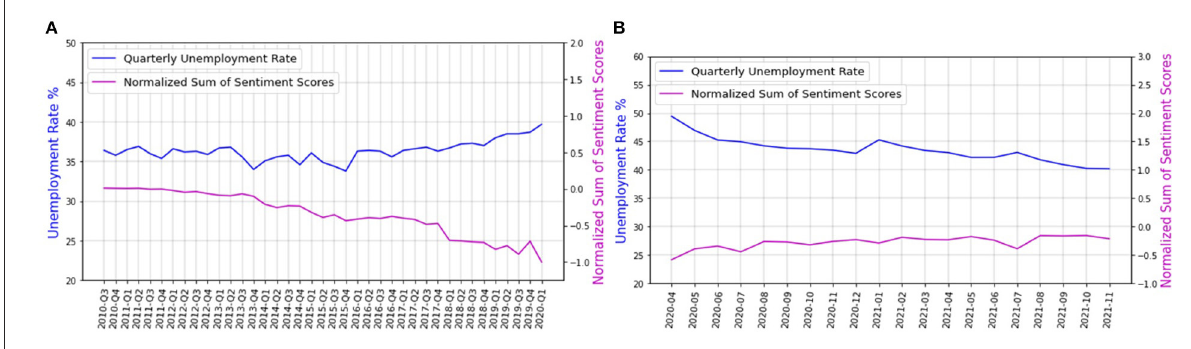
FIGURE6 The distribution of the sum of sentiment scores over time (A) before and (B) during the COVID-19 pandemic.